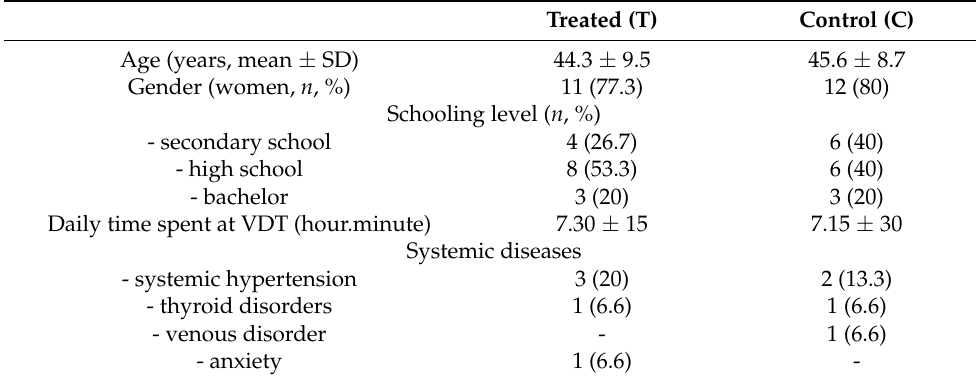
Table 1. Demographics at